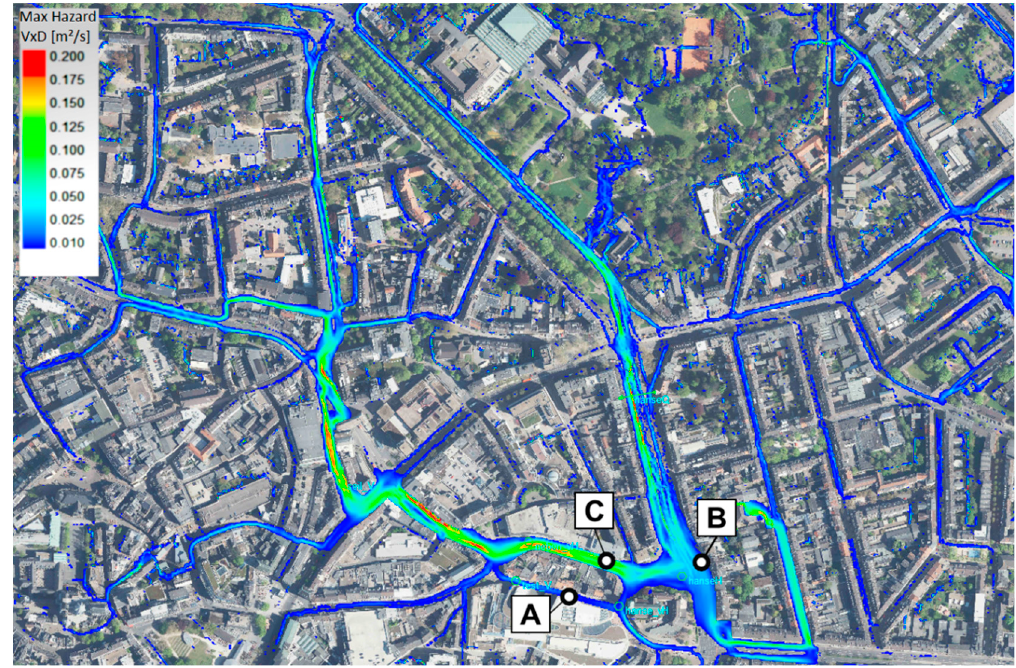
Figure 8. Hydrodynamic simulation of maximum flood impulse [m 2 /s] (product of velocity V and flow depth D) with view on the central area Kaiserplatz in the study site of Aachen.